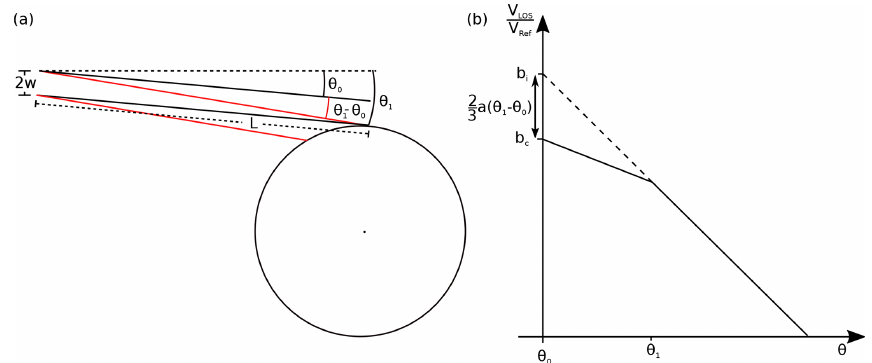
Figure 7. (a) Illustration of the definition of θ 0 and θ 1 . θ 0 is the angle compared to horizontal where the bottom of the beam first touches the wheel (beam drawn in black) and correspondingly θ 1 is the angle where the top of the beam first touches the wheel (red beam). (b) Illustration of the relation between the angles θ 0 and θ 1 , and the fit intercept b i and the corrected intercept b c